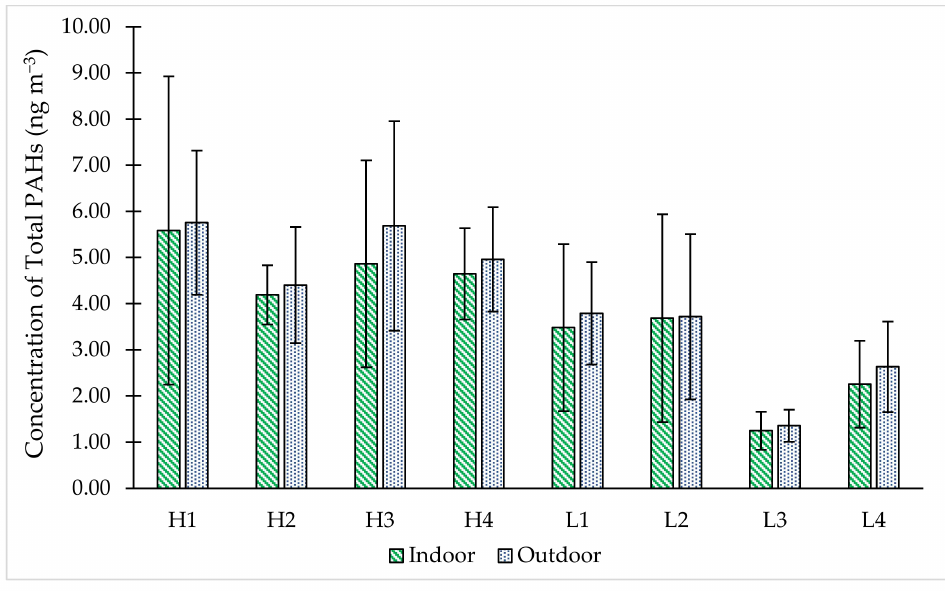
Figure 2. The concentrations of total PAHs in indoor and outdoor environment at each school. An urban middle school in Beijing China recorded 6 times higher total PAHs con- centration than the present study with the concentration of 29.8 ng m − 3 and 33.7 ng m − 3 for indoor and outdoor, respectively [37]. They had identified BbF, CYR, IcP, Flu,